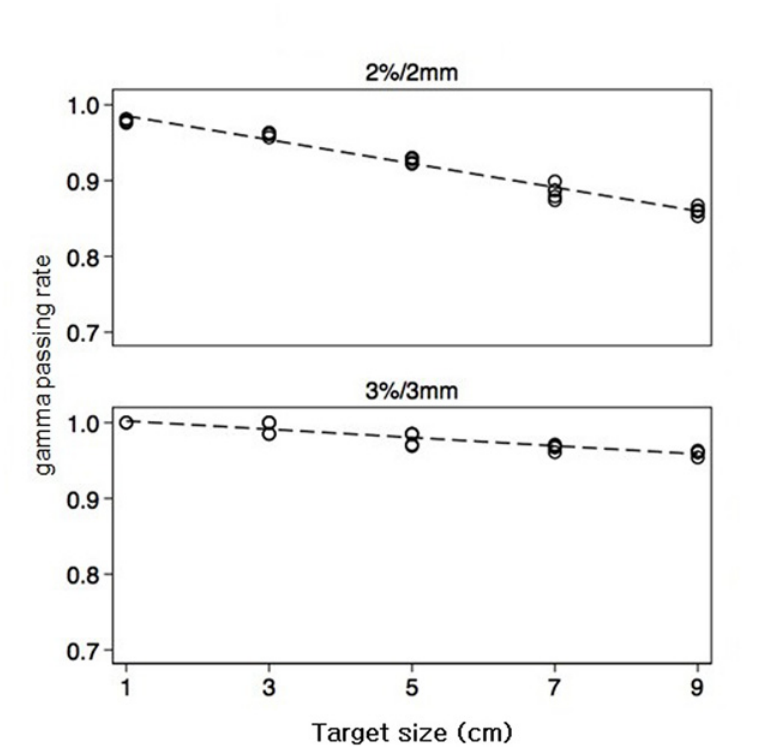
Fig 3. Variations of gamma passing rates at the diode level with various target sizes. The gamma passing rates were calculated with both the 3%/3 mm criterion (lower graph) and the 2%/2 mm criterion (upper graph) in absolute doses with a threshold of 5%. The gamma passing rate decreased as the target size increased.